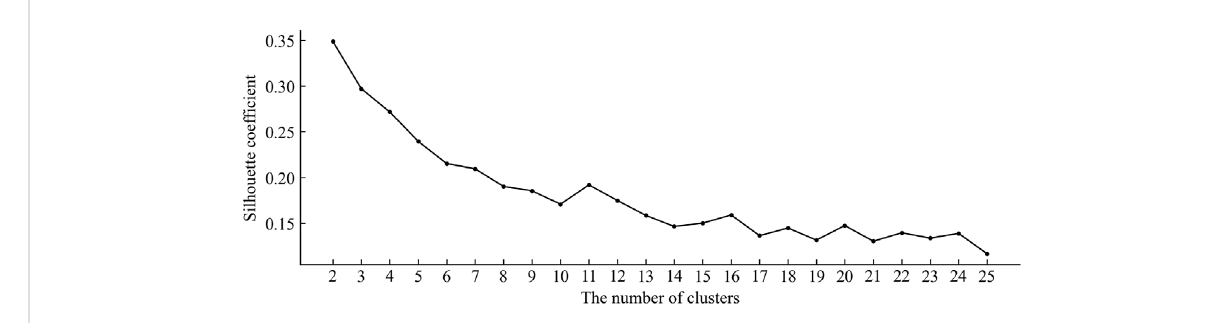
FIGURE 4 The silhouette coef fi cient of clustering results under different numbers of clusters.